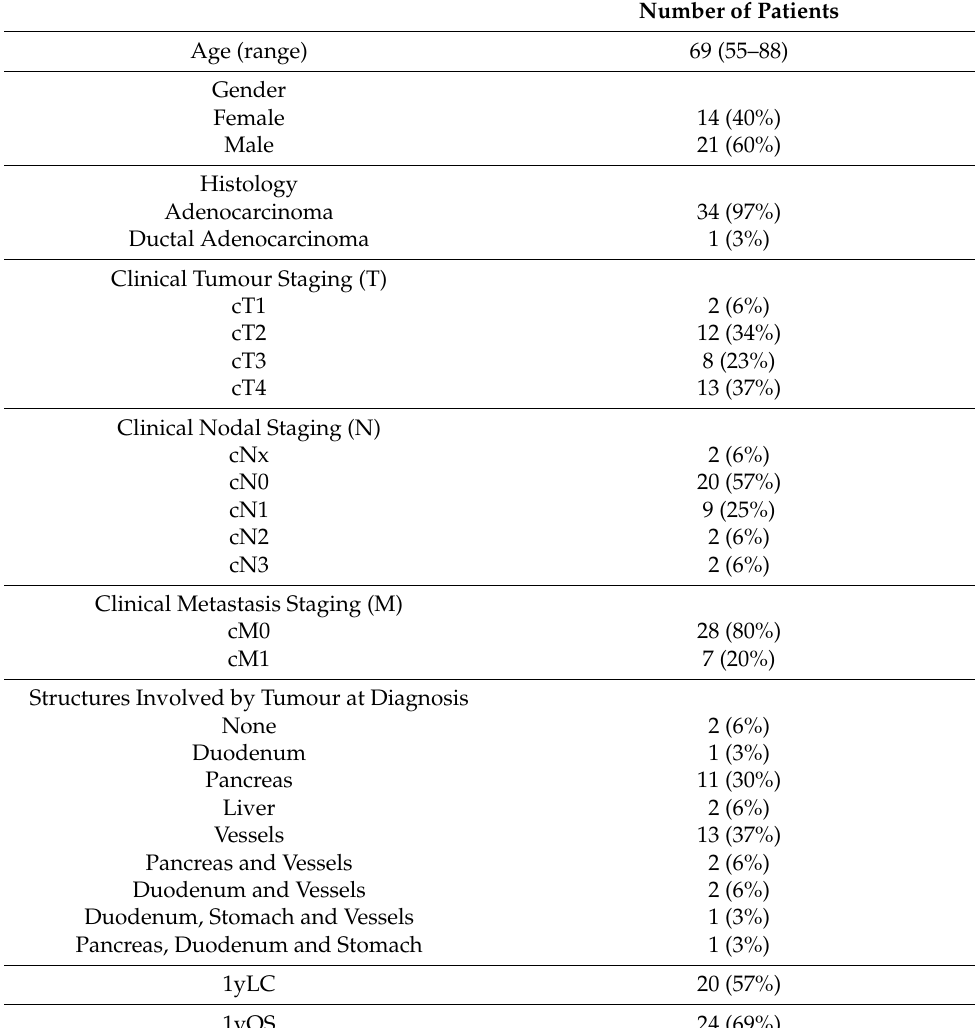
Table 2. Patient characteristics and outcomes distribution for the patients included in the study. 1yLC: Local control after 1 year since the end of the